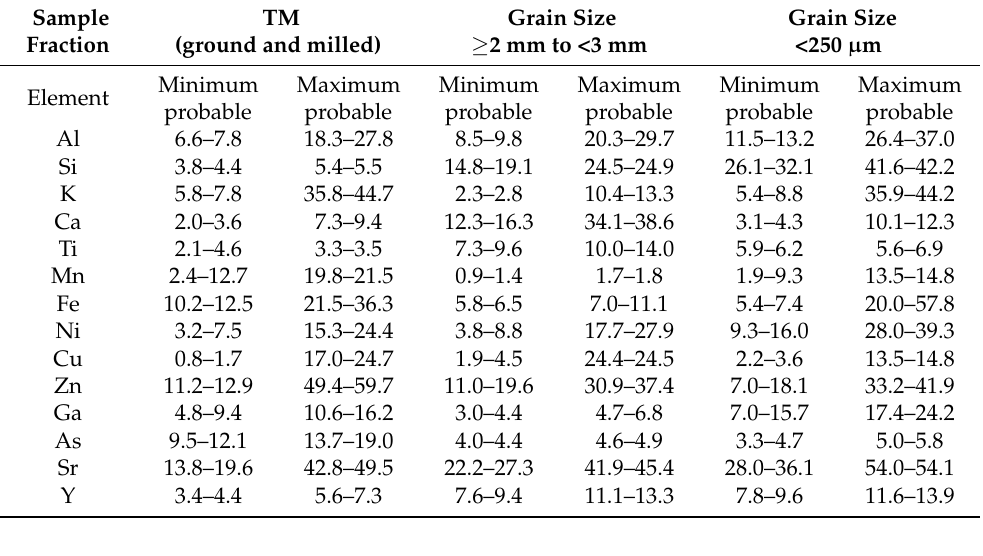
Table 2. Synthesis of estimated minimum and maximum elemental occurrence (percentage of area %)